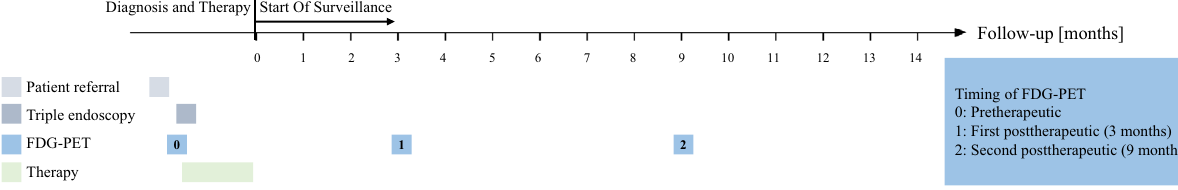
Figure 1. Graphical representation of pre- and post-treatment algorithm at our clinic. Upon referral, patients received triple endoscopy. FDG-PET is obtained as indicated. Patient are treated according to our multidisciplinary tumor board decision. After definitive therapy, patients enter post-therapeutic follow-up for 60 months. If FDG-PET was performed before therapy, this is repeated in the post-therapeutic setting at 3 and 9